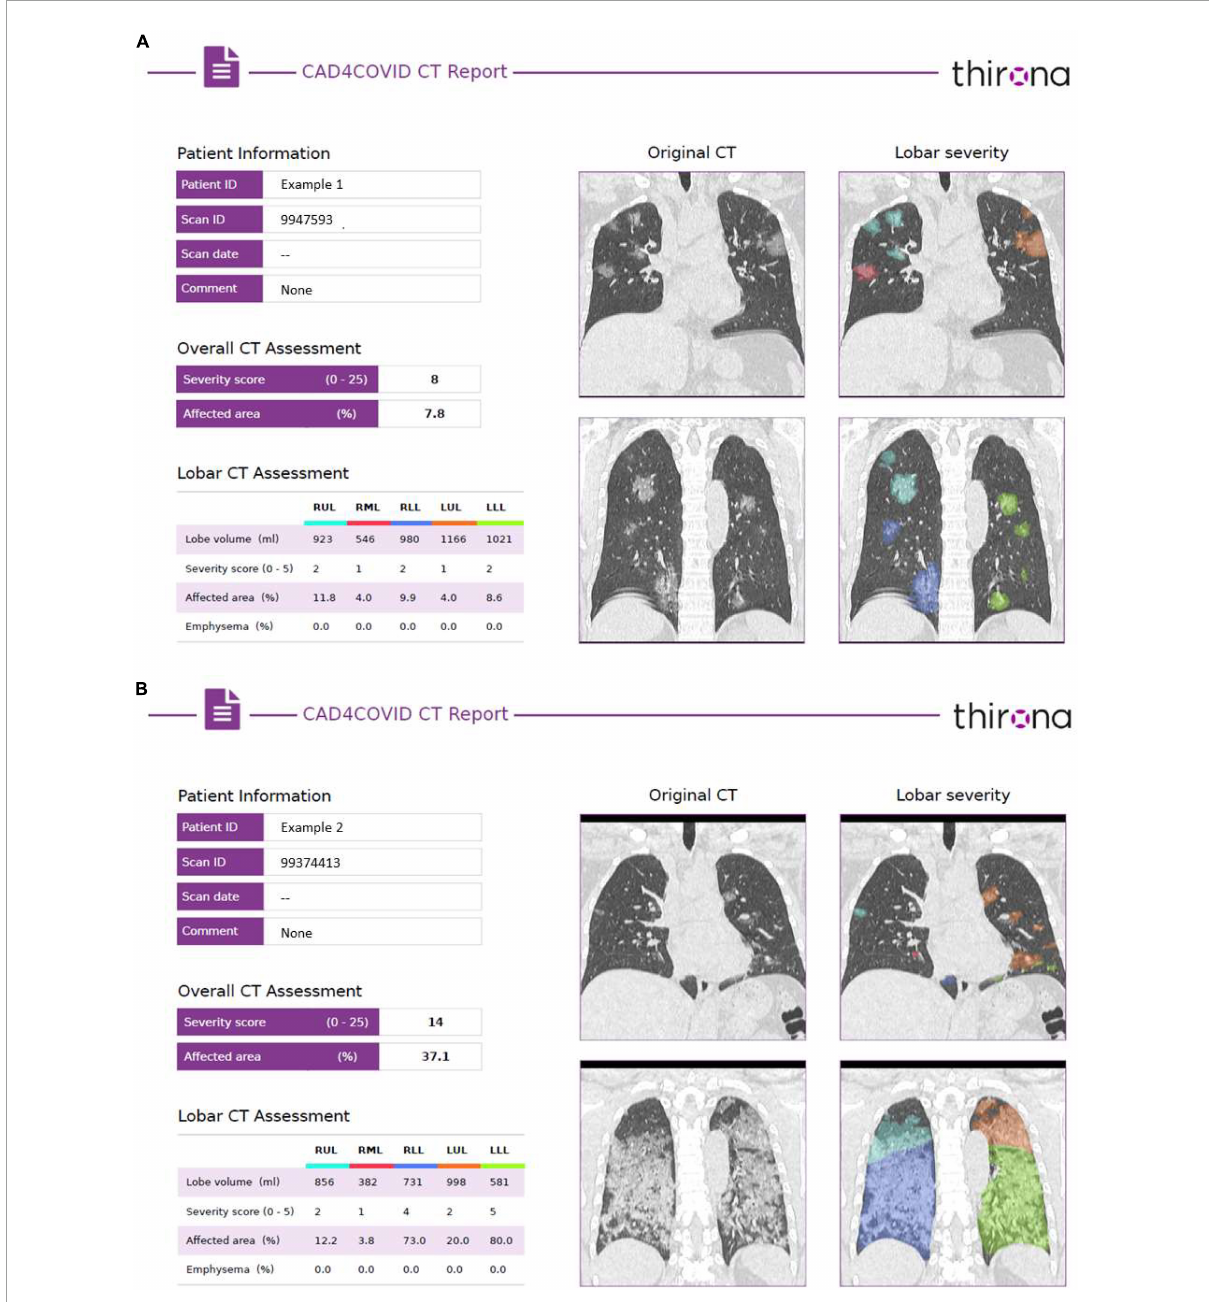
FIGURE1 Example of the CAD4COVID-CT reports of two patients with COVID-19. (A) The left side of each report provides the quantitative assessment, including the lobar volume, the total and lobar CT severity scores and% affected area, and the lobar emphysema scores. (B) The right side of each report shows two coronal sections with a color-coated overlay of the identified affected areas, where each color represents a different lobe matching the colors indicated in the lobar CT assessment table.